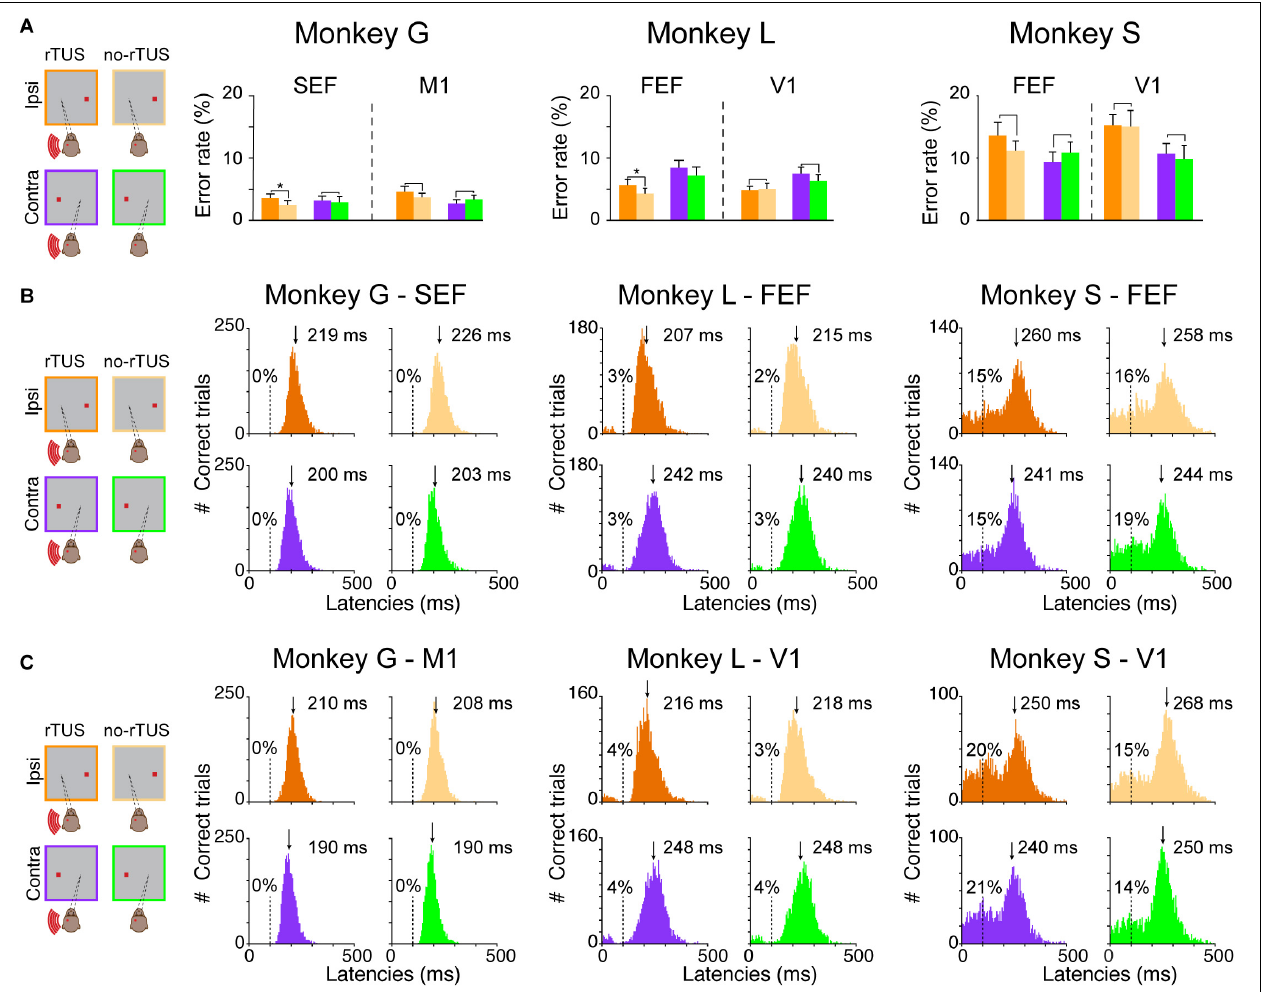
FIGURE 2 | Behavioral performances during the antisaccade task. (A) Percentage of error rates for all three animals (monkey G; left quadrant, monkey L; middle quadrant and monkey S; right quadrant). Each bar represents the mean error rates for the post-rTUS blocks for the different conditions (violet/orange for contralateral vs. ipsilateral antisaccades, respectively, and dark/light and violet/green for rTUS vs. no-rTUS, respectively). Error bars indicate the standard error of the mean (SEM). We compared rTUS vs. no-rTUS mean error rates for each condition using a Wilcoxon rank sum test (* p < 0.05). Note that the performance for all conditions (ROI, Control, Contra, and Ipsi) were similar ( p > 0.05) for all three animals except for monkeys G and L who made significantly more errors when rTUS was directed toward FEF/SEF regions for ipsilateral antisaccades. (B,C) Antisaccade latencies (ms) for all conditions [Contra/Ipsi, rTUS/no-rTUS for each animal (Monkeys G, L, and S), when the transducer was directed toward the oculomotor (B) or the control (C) areas]. The latencies were pooled over the pre-stimulation block (practice) and the next six post-rTUS blocks for each condition. The percentages indicate the percentage of anticipated saccades ( < 100 ms, dashed lines) over the total number of trials for each condition. For each histogram, the downside arrow indicates the median latency (ms) with the cutoff of anticipations.